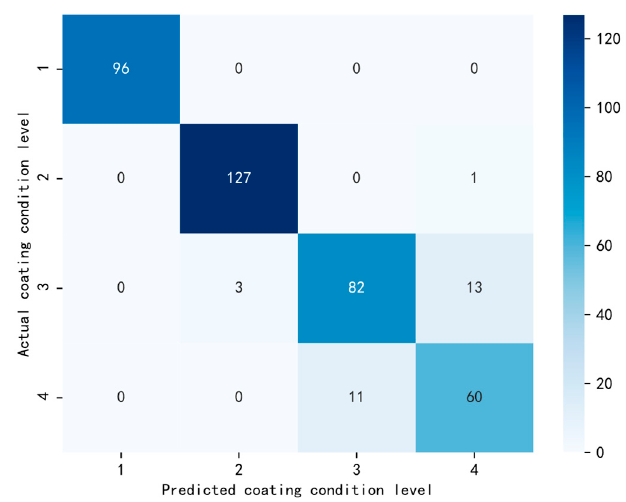
Figure 6. The confusion matrix for the testing set.